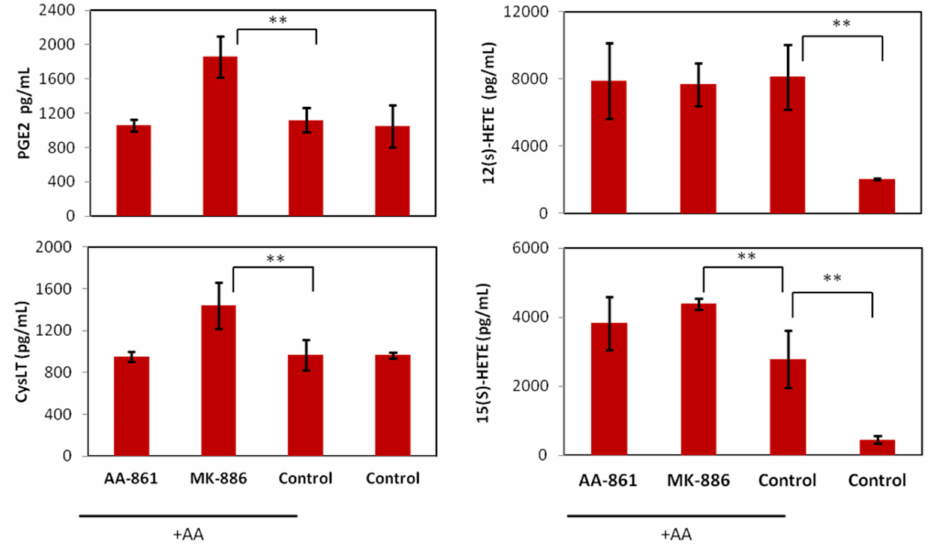
Figure 7. Effects of AA-861 and MK-886 eicosanoid biosynthesis by B16F10 cells. Biosynthesis of PGE2, CysLT, 12(S)- and 15(S)-HETE acid (pg/mL) after 3 h incubation with IC 50 of the inhibitors plus 10 µ M AA. Values are the mean of three independent assays. Error bars represent SD. Statistical significance by two-tailed unpaired t -test (** p <